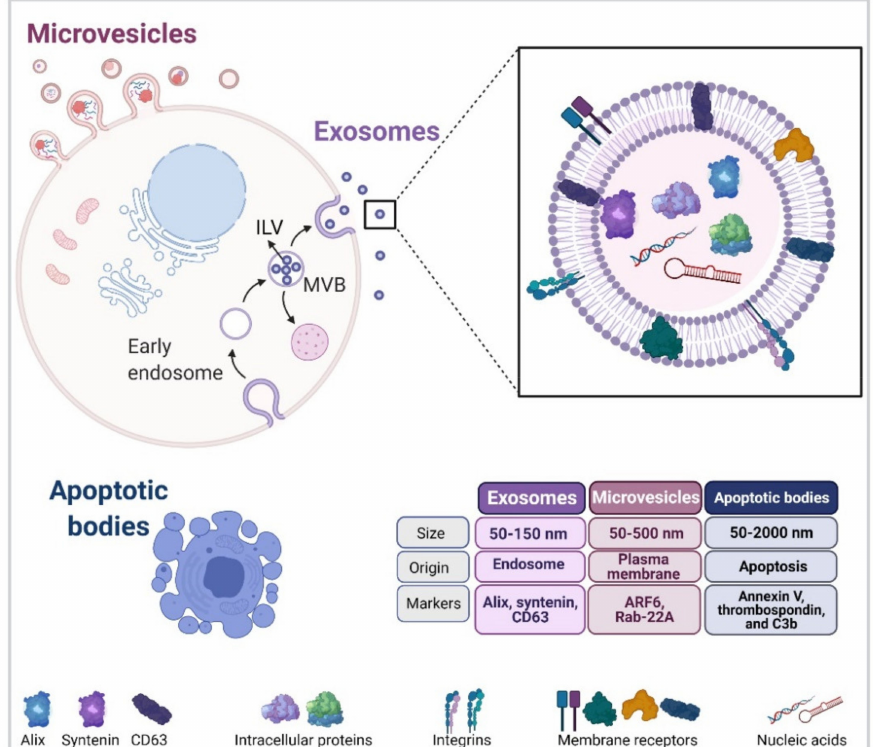
Figure 1. Extracellular vesicles are a heterogeneous population of cell-derived membrane vesicles. Extracellular vesicles (EVs) have classically been divided into three types according to their biogenesis and biophysical properties: exosomes, microvesicles, and apoptotic bodies. Recently, a new group of non-membranous nanoparticles of less than 50 nm, called exomeres, was identified. However, still, little is known about their biogenesis, and proteins that have been connected to exomeres must be characterized further in order to validate them as markers. For this reason, they are not included here. EVs are carriers of a variety of molecules, including proteins, nucleic acids, and lipids. The insert with a close-up view of exosomes shows some molecules commonly transported by